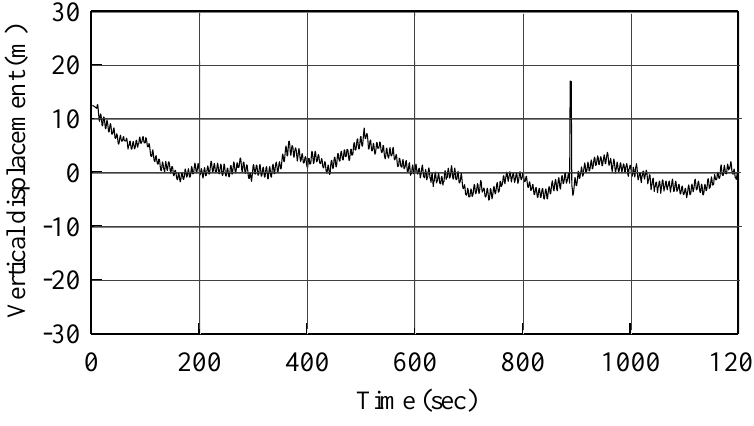
Figure 7. Vertical displacement outputted directly from GPS receiver (T = 6